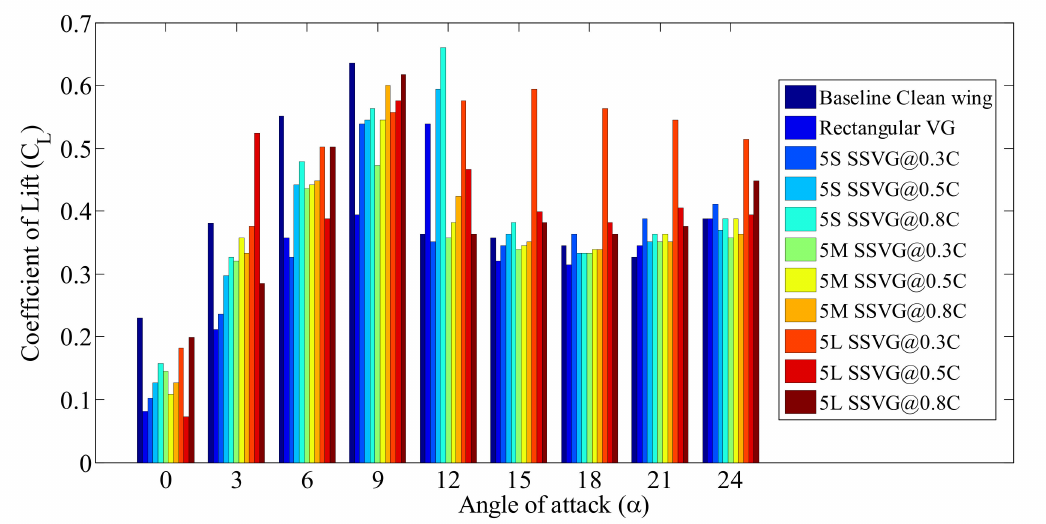
Figure 19. Comparison of the coefficient of lift ( C L ) over baseline and modified wings with 5S, 5M, and 5L SSVG at various chordwise locations.